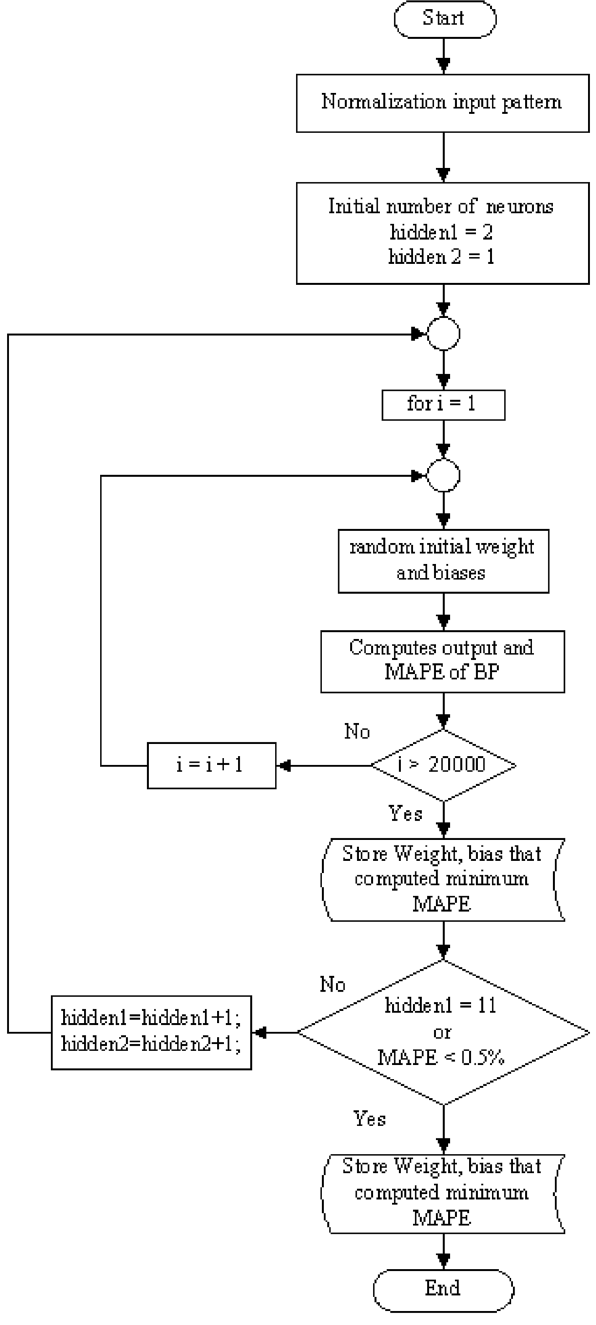
Figure 10. Flowchart of BPNN training